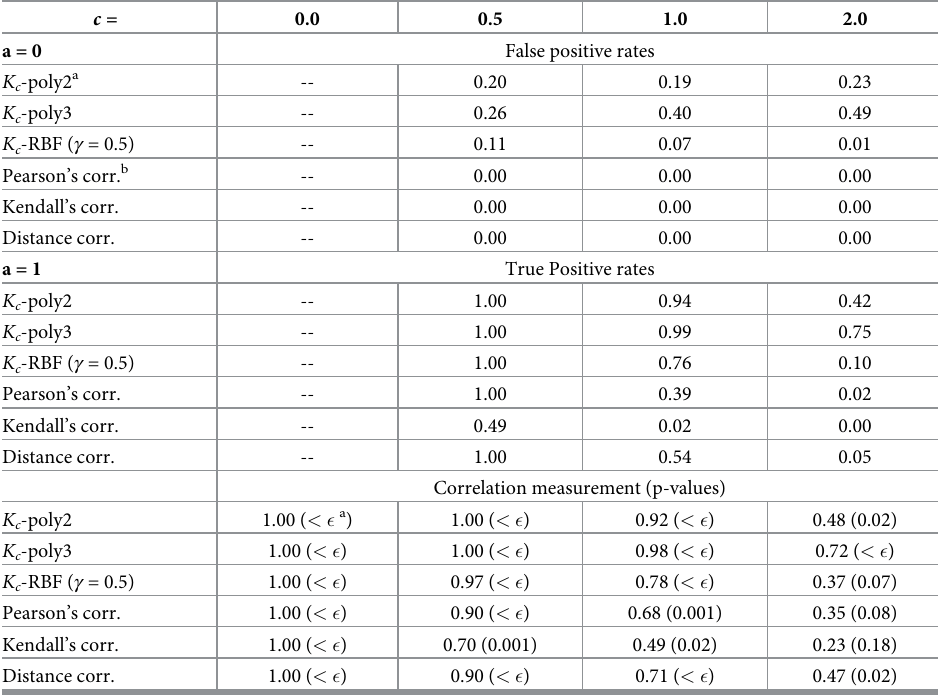
Pearson’s corr. Kendall’s corr. Distance corr. 1.00 ( < � ) 0.90 ( < � ) 0.71 ( < � ) 0.47 (0.02) a K c -poly2, K c -poly3, and K c -RBF denote K c with the polynomial kernel of degree 2 and 3, and the RBF kernel, respectively. b The notation corr. and � denote correlation coefficient and 5 � 10 -4 ,